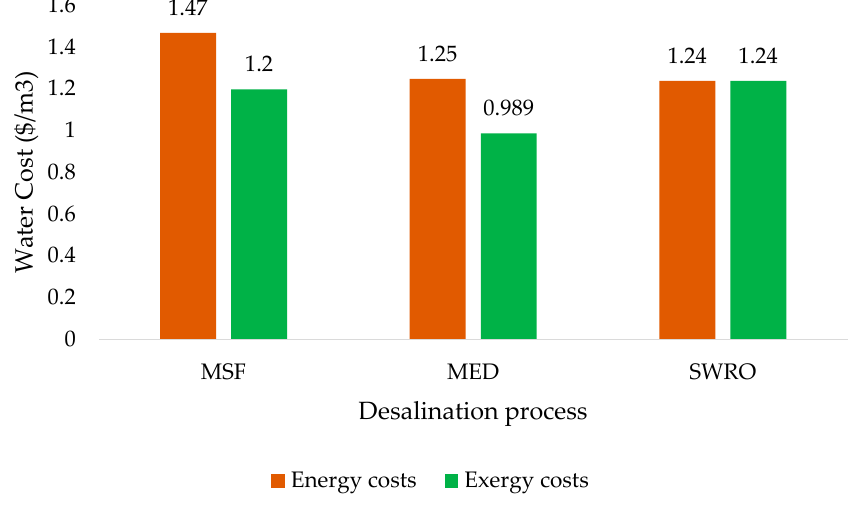
Figure 17. Comparison of energy and exergy costs of common desalination processes.